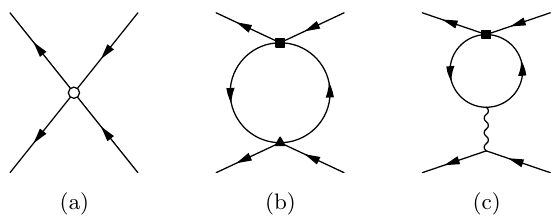
Figure 3 . Diagrams contributing to the Wilson coe(cid:14)cient of ((cid:22) e iL (cid:13) (cid:22) e jL ) ((cid:22) e kL (cid:13) (cid:22) e nL ) below the electroweak scale m EW . Only light (cid:12)elds (thin lines) are present. The four-fermion interaction (empty circle) of diagram (3.a) is the unknown of the matching procedure. The triangle in diagram (3.b) denotes the SM Fermi interaction. In the matching condition, the diagram (3.b) is canceled by the diagram (2.e) and the diagram (3.c) is canceled by the diagram (2.f). Lagrangian and the amplitude is given by the sum of the diagrams in (cid:12)gure 3. The diagram (3.a) represents our unknown. By equating the amplitudes above and below m